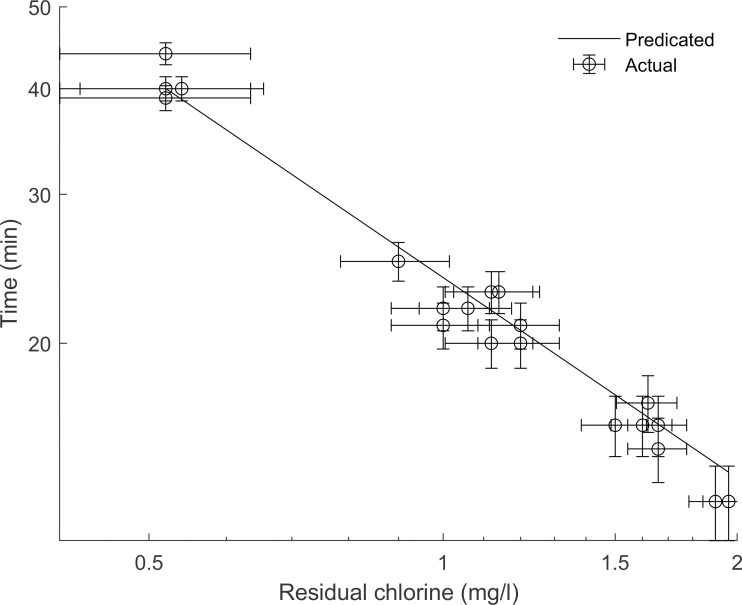
Residual chlorine (mg/l) and time (min) required to achieve a 2.0±0.1 log inactivation of S. mansoni cercariae.Data shown is for pH 7.5 and 20°C. Eq 2 was used to yield predicted time values given actual residual chlorine values. Error bars show uncertainty in measurements arising from experimental error.